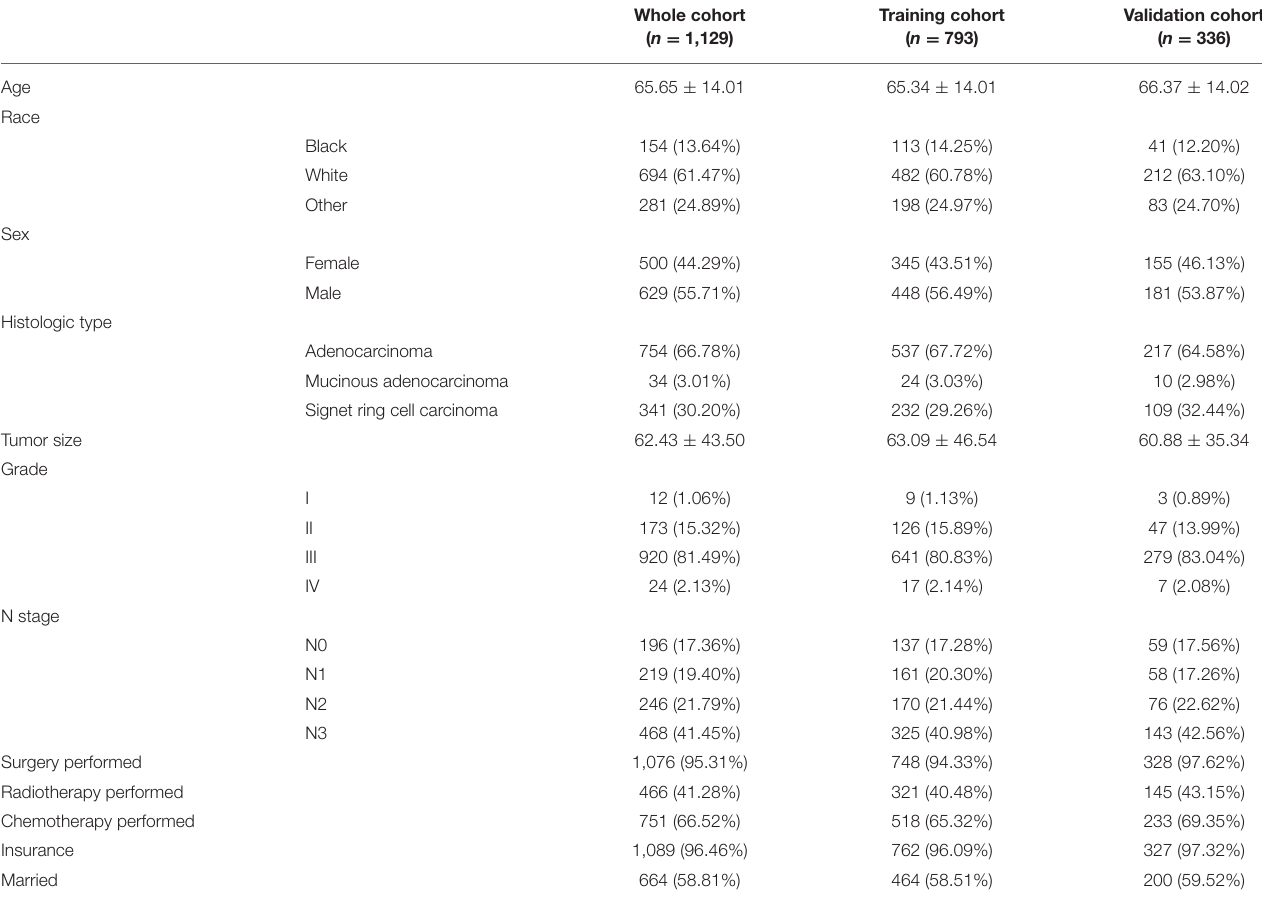
TABLE 2 | Baseline information of 1,129 patients T4aN0-3M0 gastric